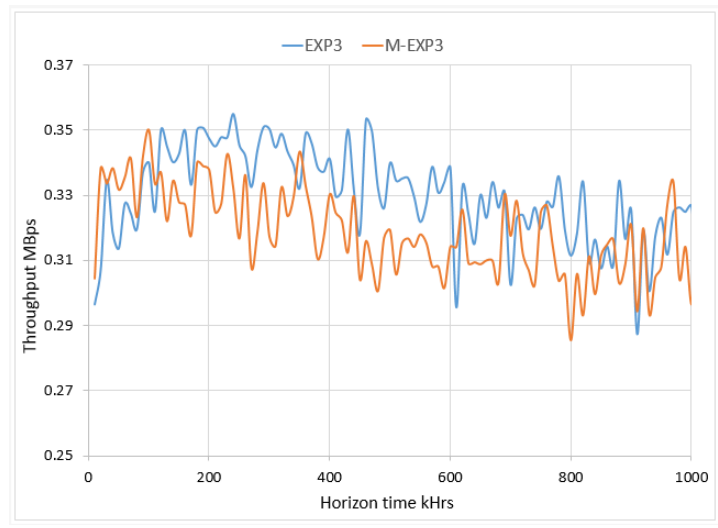
Figure 6. Comparison of the